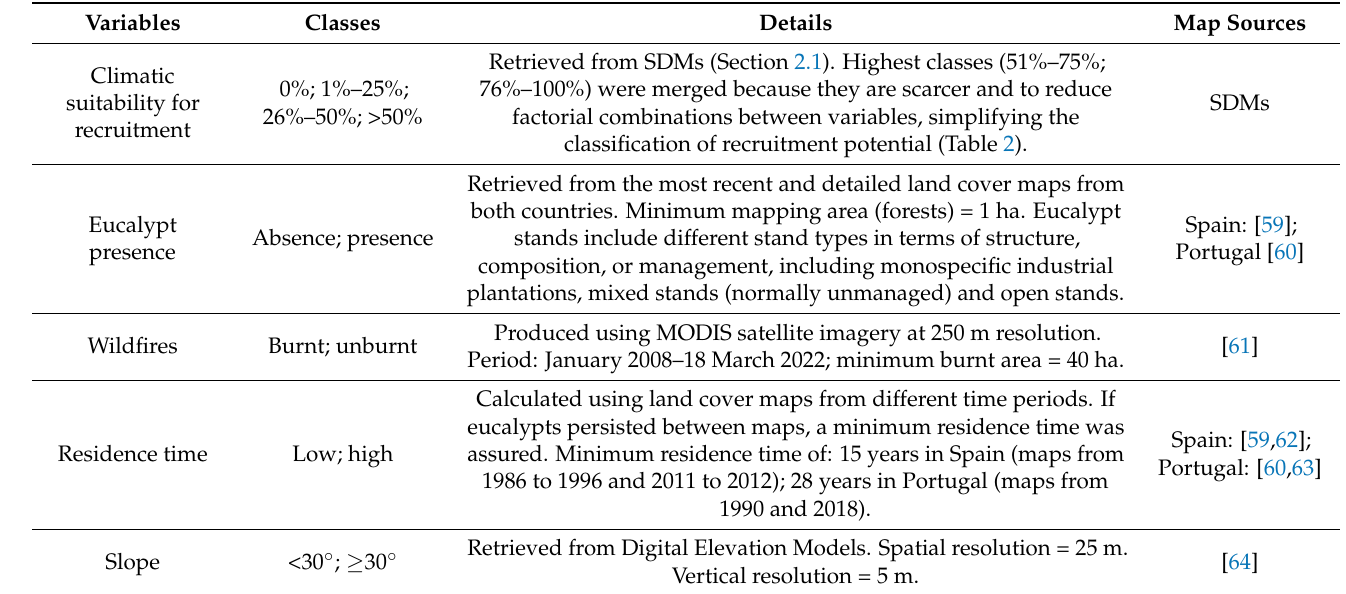
Table 1. List of variables used to estimate recruitment potential and invasion potential.